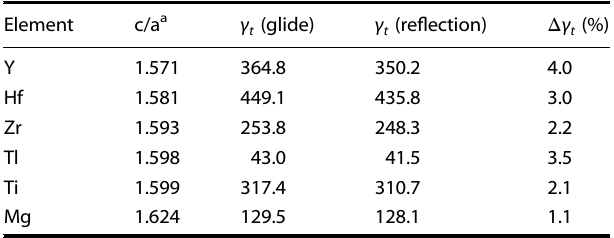
The energy is in mJm − 2 . Δ γ t = ( γ t (glide)- γ t (re fl ection))/ γ t (glide) a experimental values taken from ref. 1